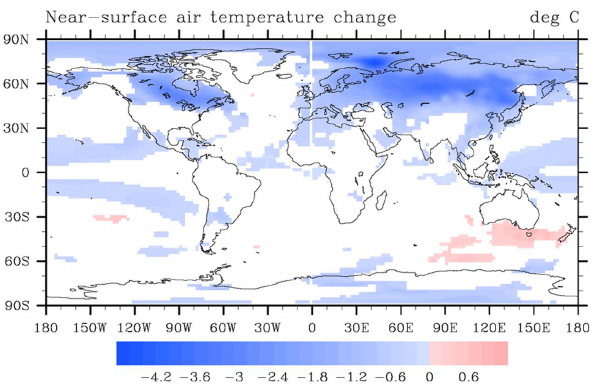
Fig. 10. The change of annual near-surface air temperature ( ◦ C) in response to high-latitude deforestation. Shown is the difference between the MPI-ESM boreal deforestation experiment, averaged over the last 20yr and the pre-industrial control simulation. Shown are only statistically significant changes ( p < 0.05).